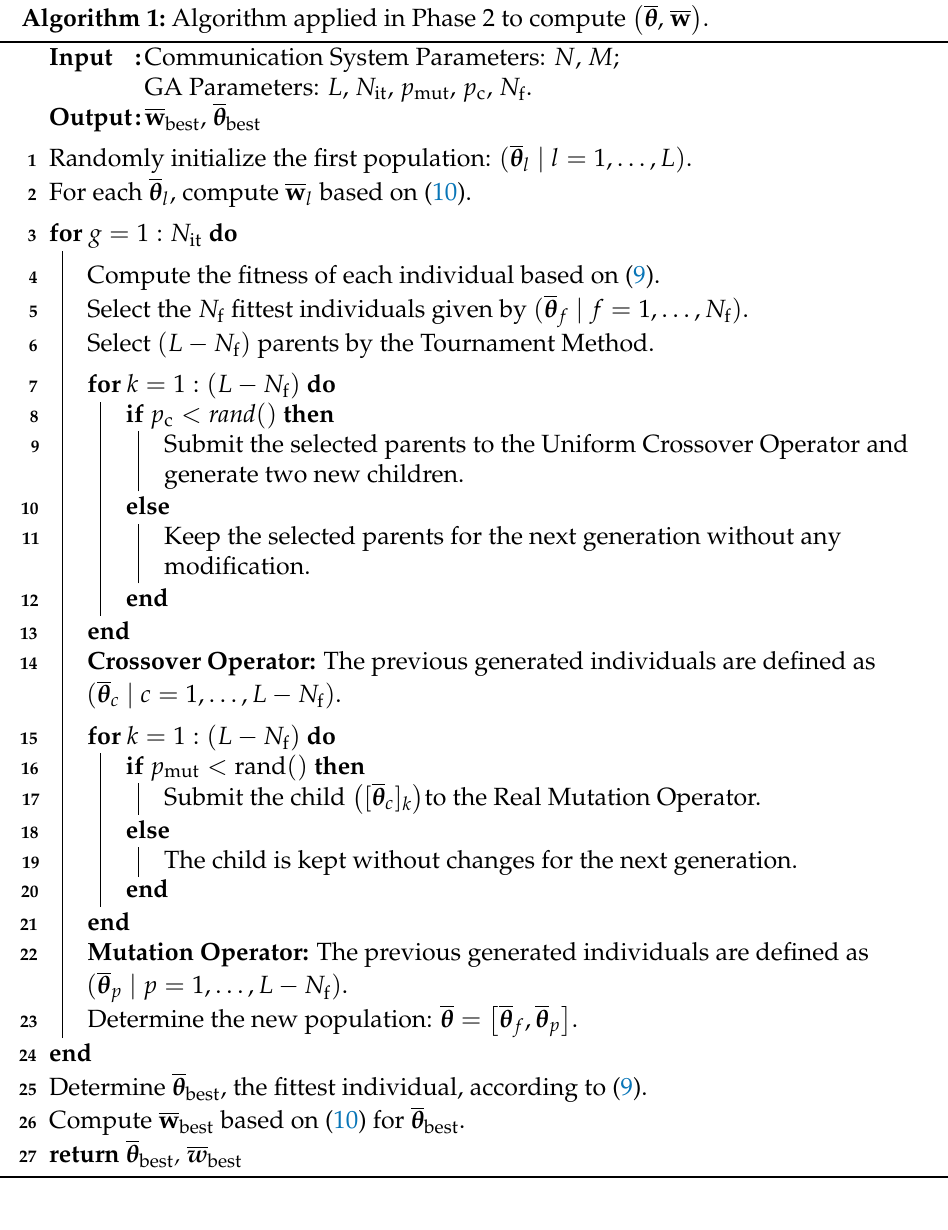
Algorithm 1: Algorithm applied in Phase 2 to compute